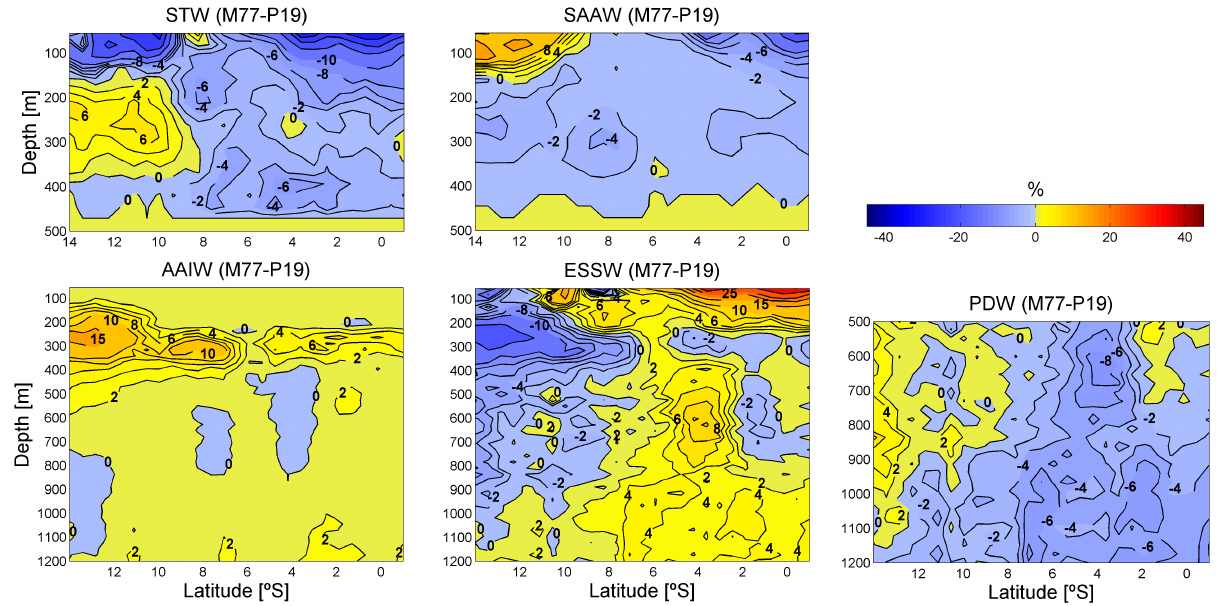
Fig. 9a. Water mass changes (%) between March 1993 and February 2009 (M77–P19) for subtropical water (STW), subantarctic water (SAAW), antarctic intermediate water (AAIW), equatorial subsurface water (ESSW) and pacific deep water (PDW).